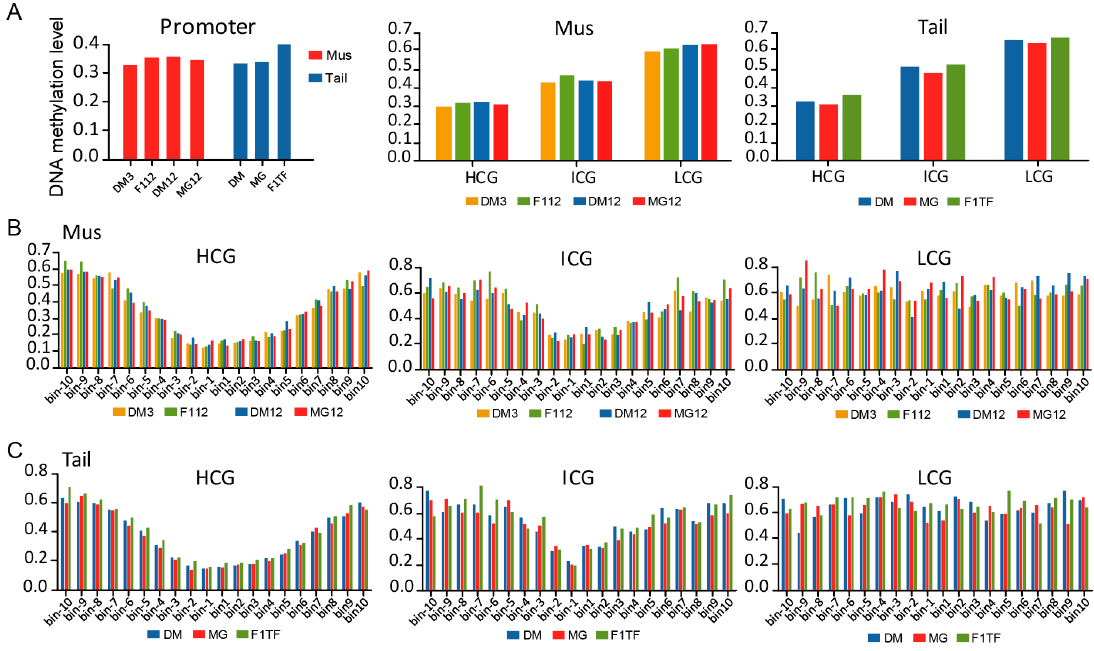
Figure 6. DNA methylation patterns of the promoter region for muscle tissue and tail-fat tissue. ( A ) Global DNA methylation level of prompter region (left), and DNA methylation of HCG, ICG and LCG-types promoter for muscle tissue (middle) and tail-fat tissue (right). ( B ) DNA methylation patterns of muscle tissue and ( C ) tail-fat tissue at the consecutive 20 bins of the promoter region.